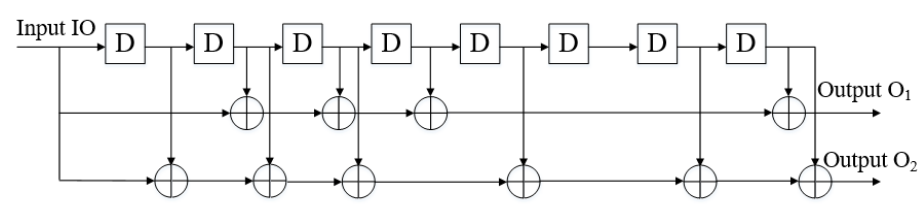
Figure 6. Convolutional code